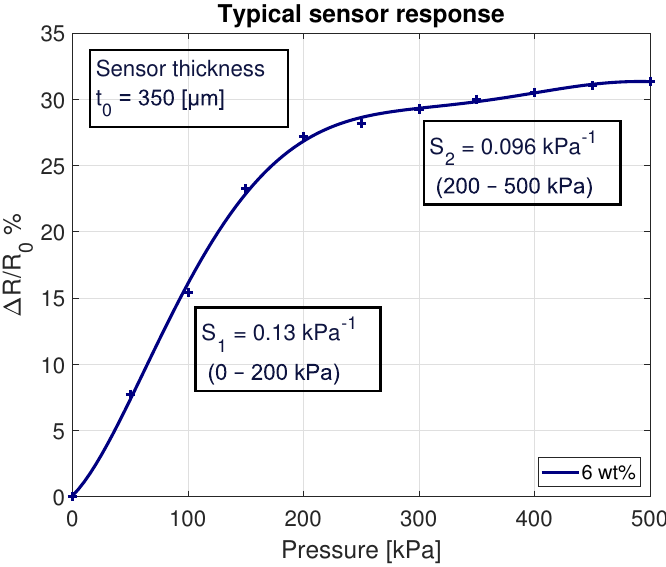
Figure 14. Typical sensor response with 6 wt% MWCNT, with a thickness of 350 µ